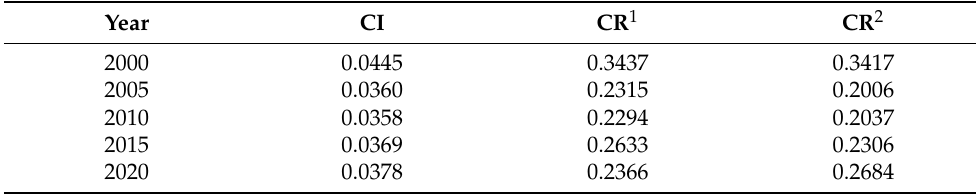
Table 4. Changes in compactness of Hangzhou in different